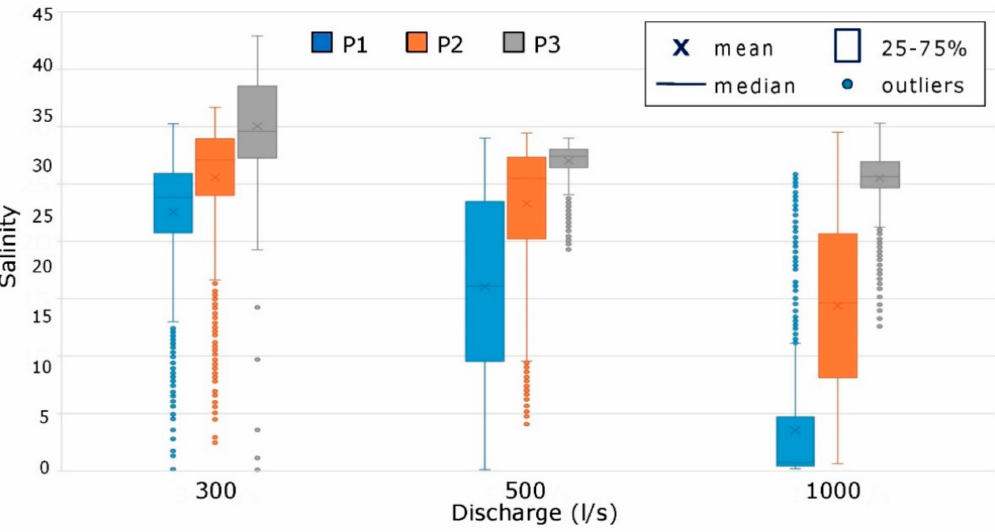
Figure 7. Box and Whisker plots relative to three periods of two weeks with different regimes of fresh water discharge are compared. Data relative to the three positions (P1-P2-P3) are reported.